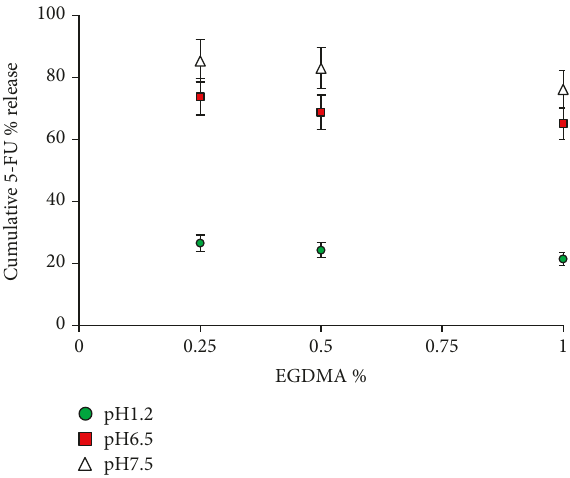
Figure 5: Release of 5-FU from Poly (CMCS- g -AA) hydrogels using di ff erent contents of EGDMA as crosslinking agent (0.25%, 0.50%, and 1% of AA) at various pH values and 37 ° C in 0.05 M USP phosphate bu ff er